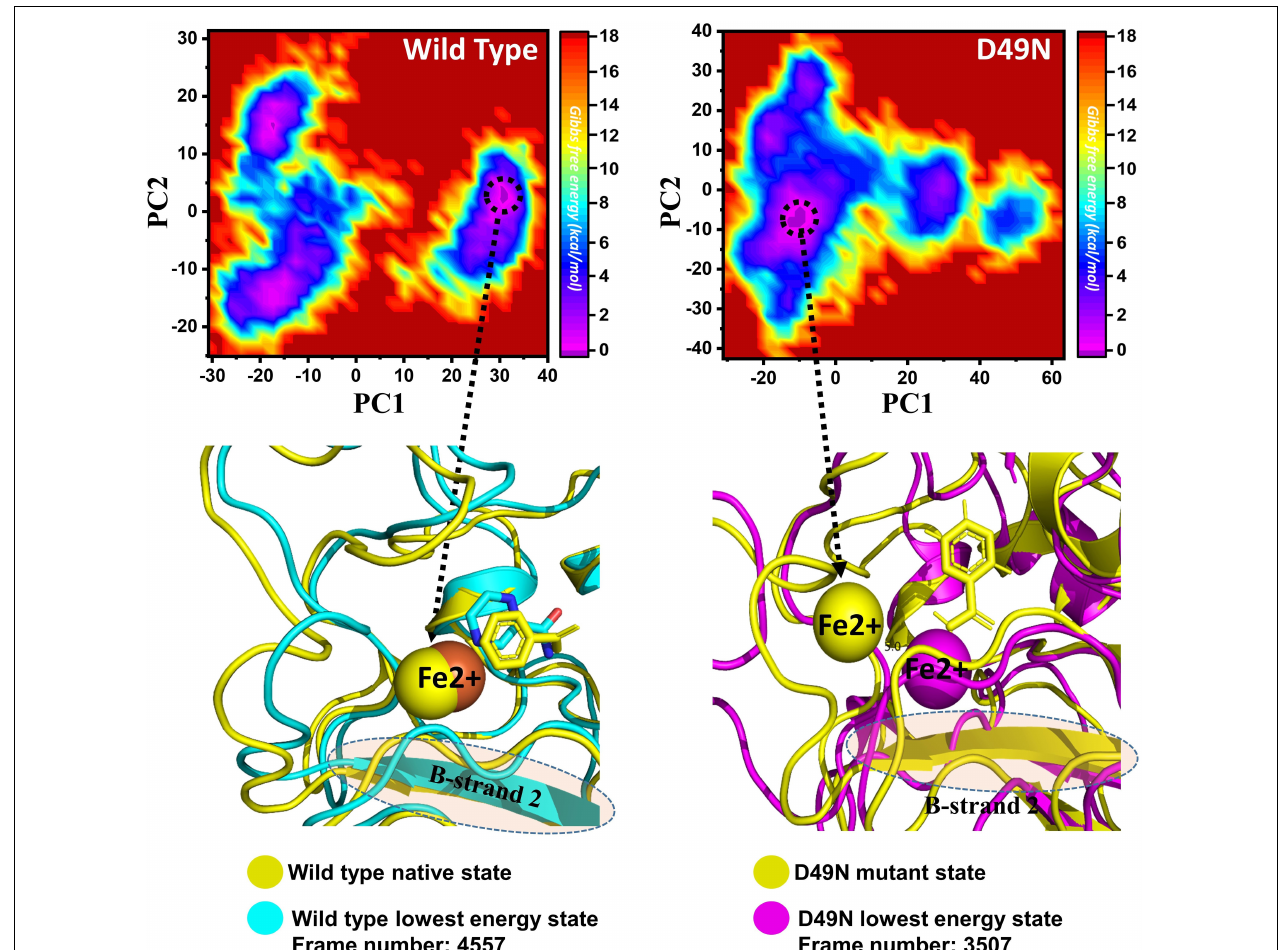
FIGURE 7 | Structural rearrangement of Fe 2 + and the other regions in the protein given above (WT and D49N mutant). The lowest energy conformation from the wild type (92 ns) for the D49N (70 ns) was extracted and compared with the native state. The circle represents the lowest energy